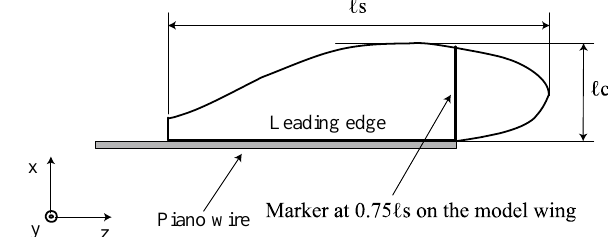
Fig.1 Planform of the enlarged flexible wing made of PPS film. The wing has marker line at 75% of span length.